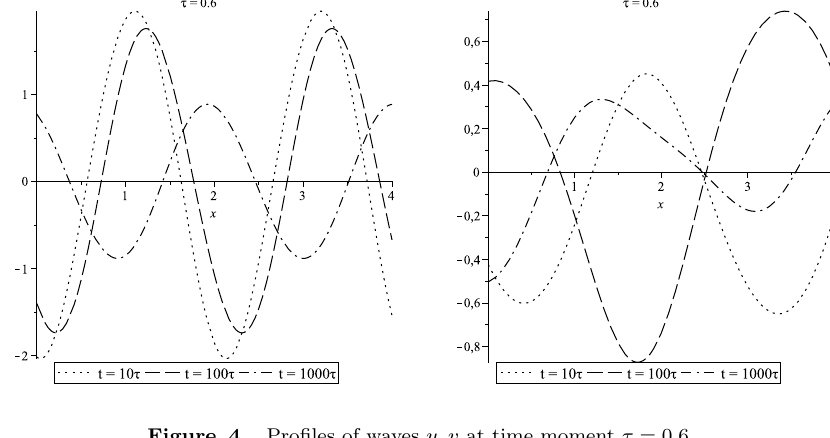
Figure 4. Profiles of waves u,v at time moment τ = 0 . 6